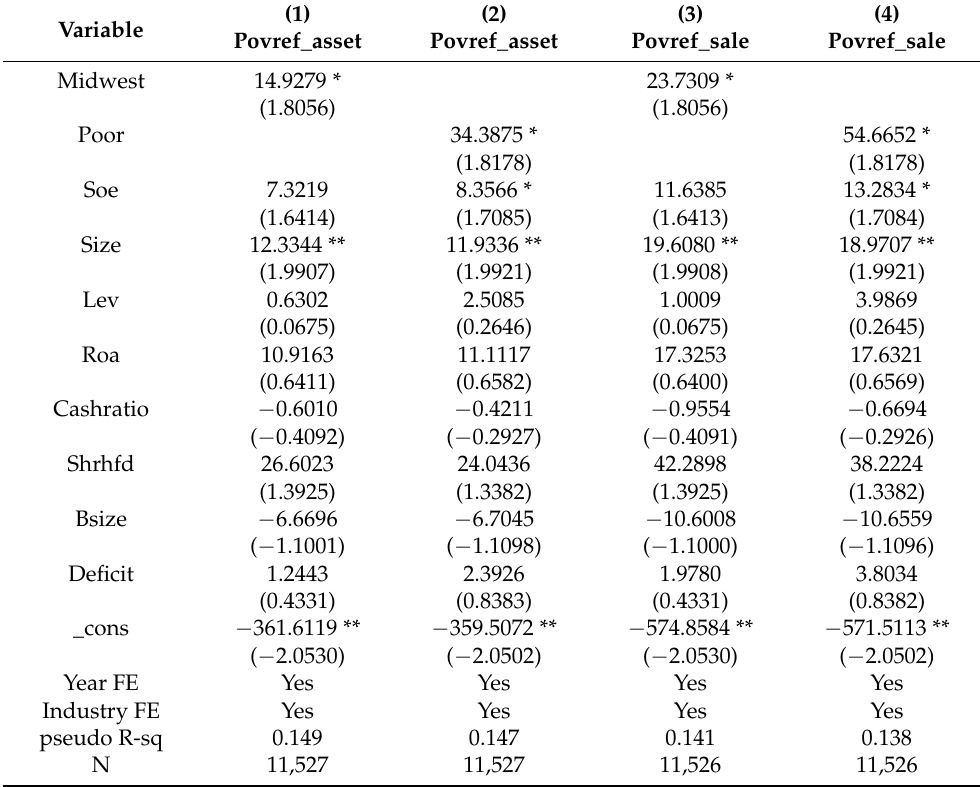
Table 8. Robustness tests: changing the measurement of ecological poverty alleviation